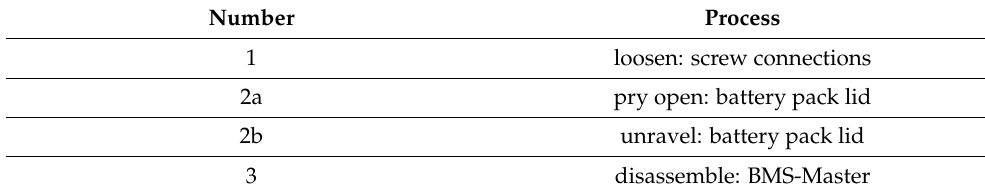
Table A8. Activities of the main processes “classification” and “disassembly”: disassembly lid.